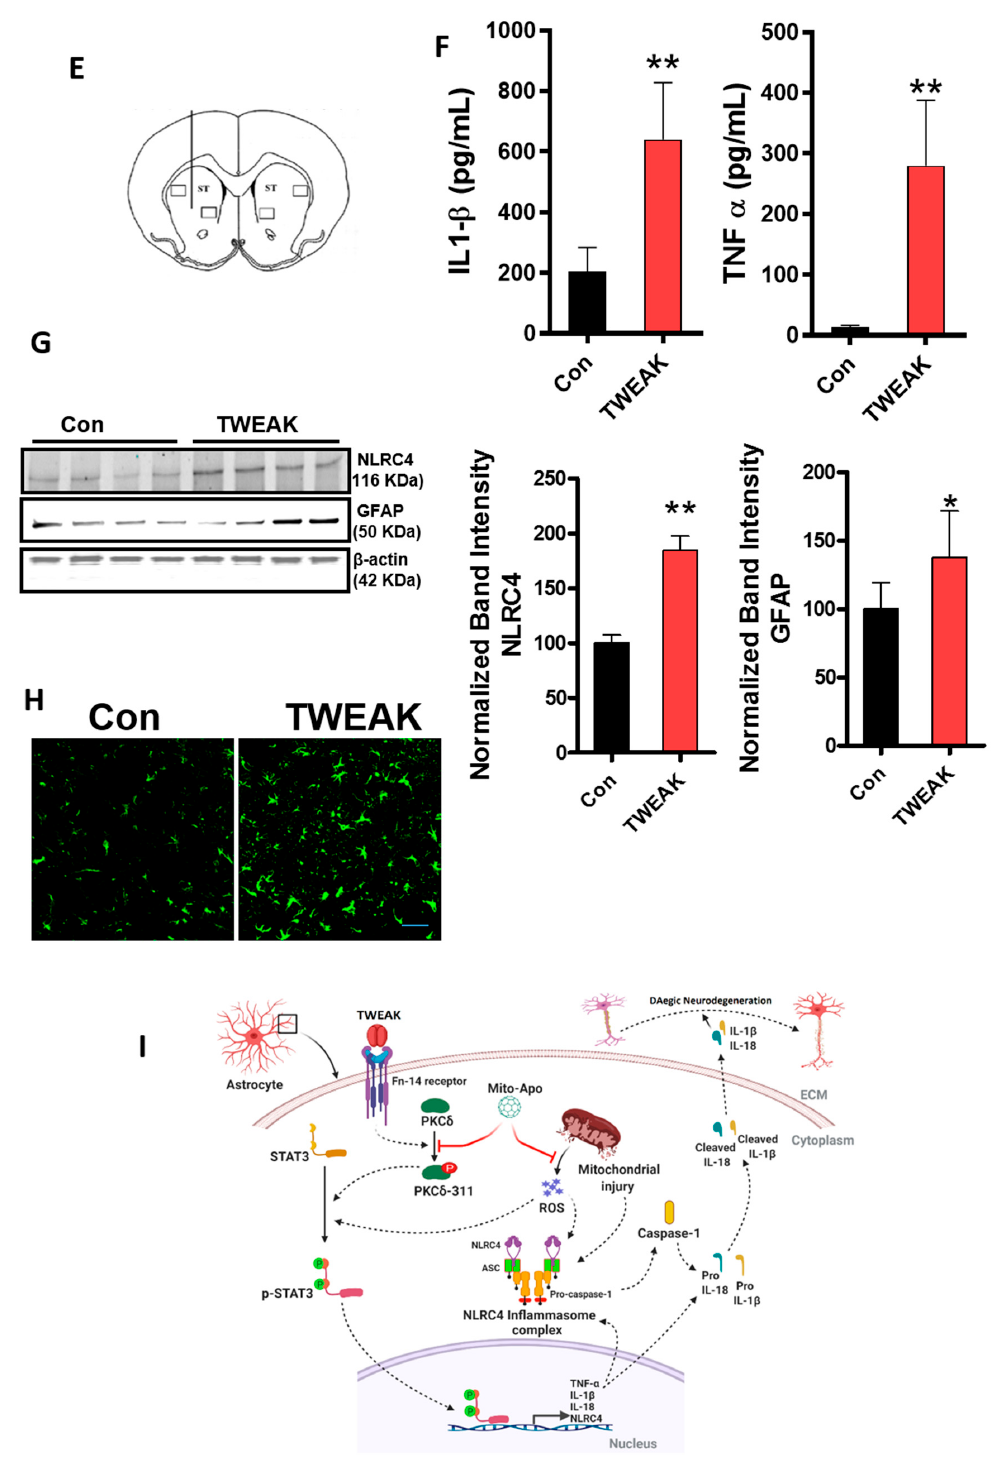
Figure 7. Enhanced TWEAK expression within activated astrocytes positively correlates with NLRC4 inflammasome activation and TH neuronal loss in the nigra of MPTP-treated mice. A similar response was evidenced in the ventral midbrain (SNpc) of mice that received an intrastriatal TWEAK injection. ( A-D ) Mice were intraperitoneally injected with MPTP (25 mg/kg) or PBS. Upon sacrifice, mouse brain tissues were harvested and used for IHC, WB and ELISA analysis. ( A ) Colocalization of TWEAK and GFAP, as assessed via IHC analysis, showed increased astrocyte activation and colocalization of TWEAK in the MPTP mice as compared to the PBS-injected mice. Scale bars = 20 µ m. ( B )